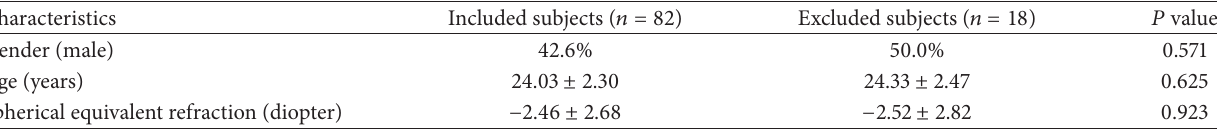
Table 1: Summary of the characteristics of subjects included and excluded from the fractal dimension